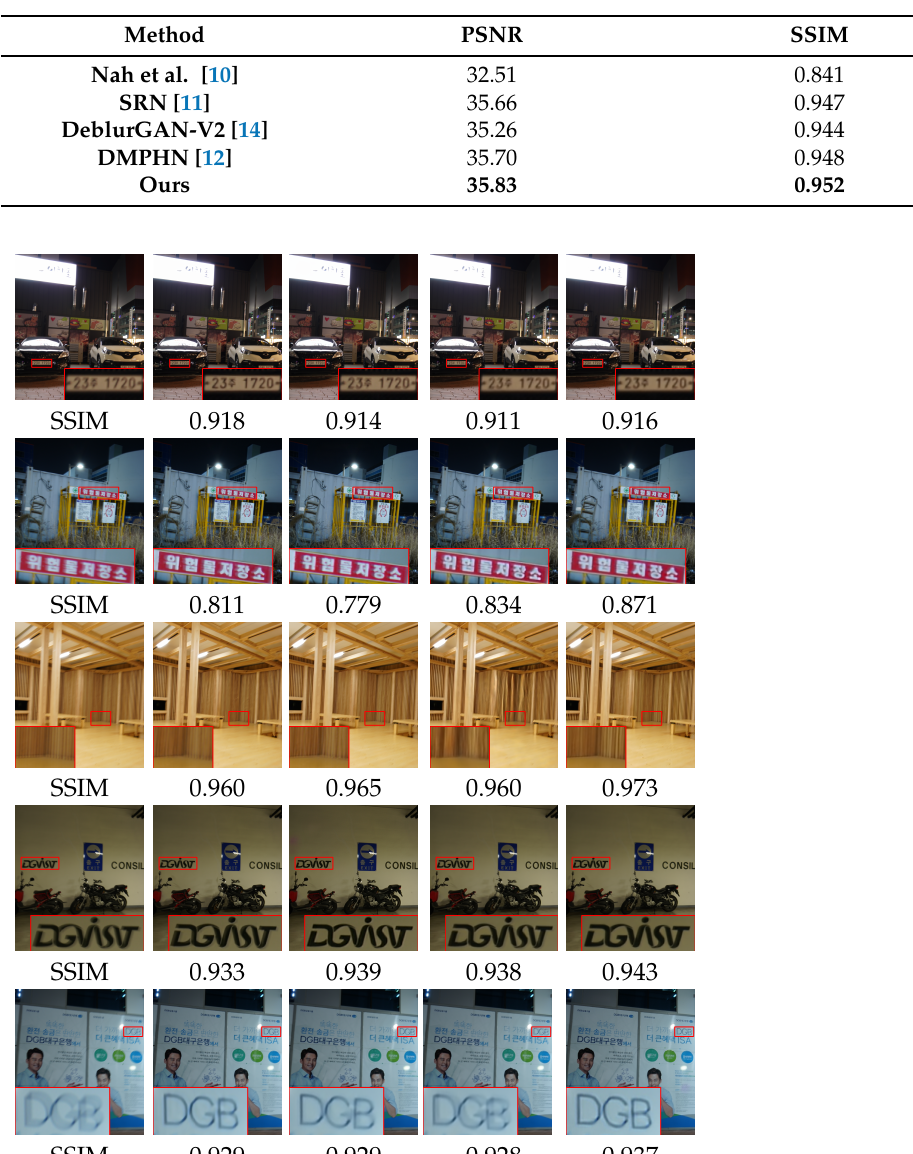
Table 3. Performance comparison on the RealBlur-R dataset.